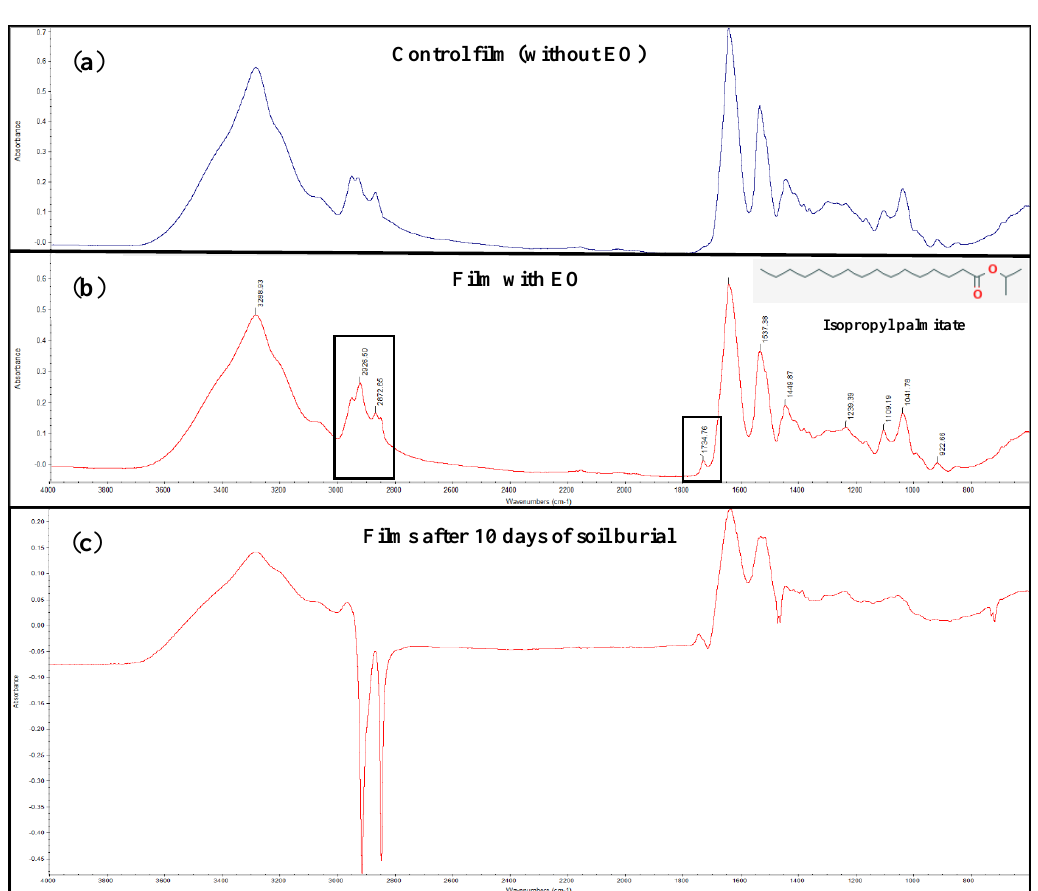
Figure 2. FTIR spectra of the films: control film (without EO) ( a ), film with EO ( b ), and films after 10 days of soil burial ( c ).